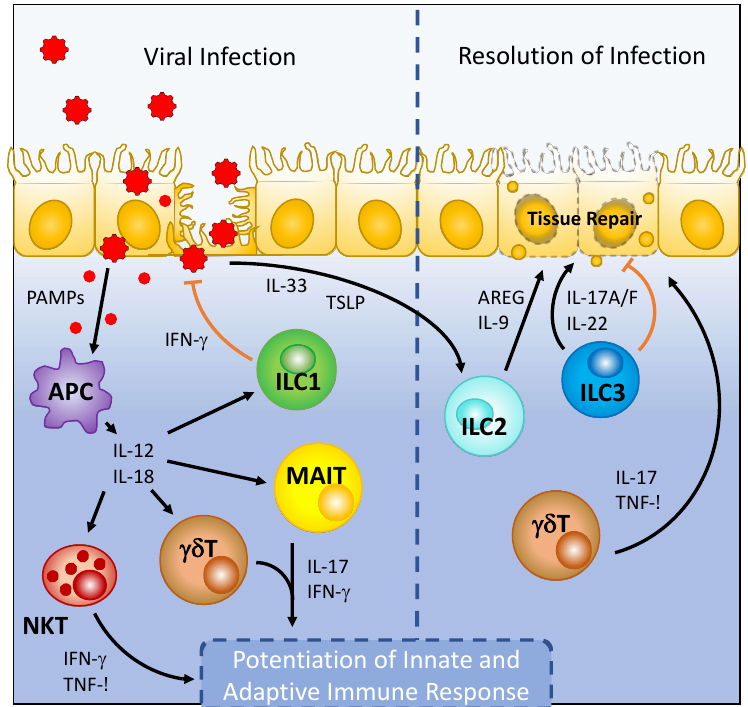
Figure 1. Viral infection leads to the activation of tissue-resident ILCs and unconventional T cell subsets. Recognition of pathogen associated molecular patterns (PAMPs) by antigen presenting cells (APC), which include tissue-resident macrophages and dendritic cells, during viral infection leads to the production of proinflammatory cytokines that include IL-12 and IL-18. IL-12 and IL-18 stimulation of ILC1, NKT, MAIT, and γδ T cells leads to robust cytokine production by these cell types to inhibit viral replication and stimulate subsequent circulating adaptive lymphocyte responses. During the recovery phase of viral infection, the release of IL-33 promotes amphiregulin production by ILC2 to promote tissue repair. Similarly, IL-22 produced by ILC3 can promote barrier integrity and directly limit viral replication to resolve viral infection. Table 1. Protective and pathologic tissue-resident lymphocyte responses to viral infection.